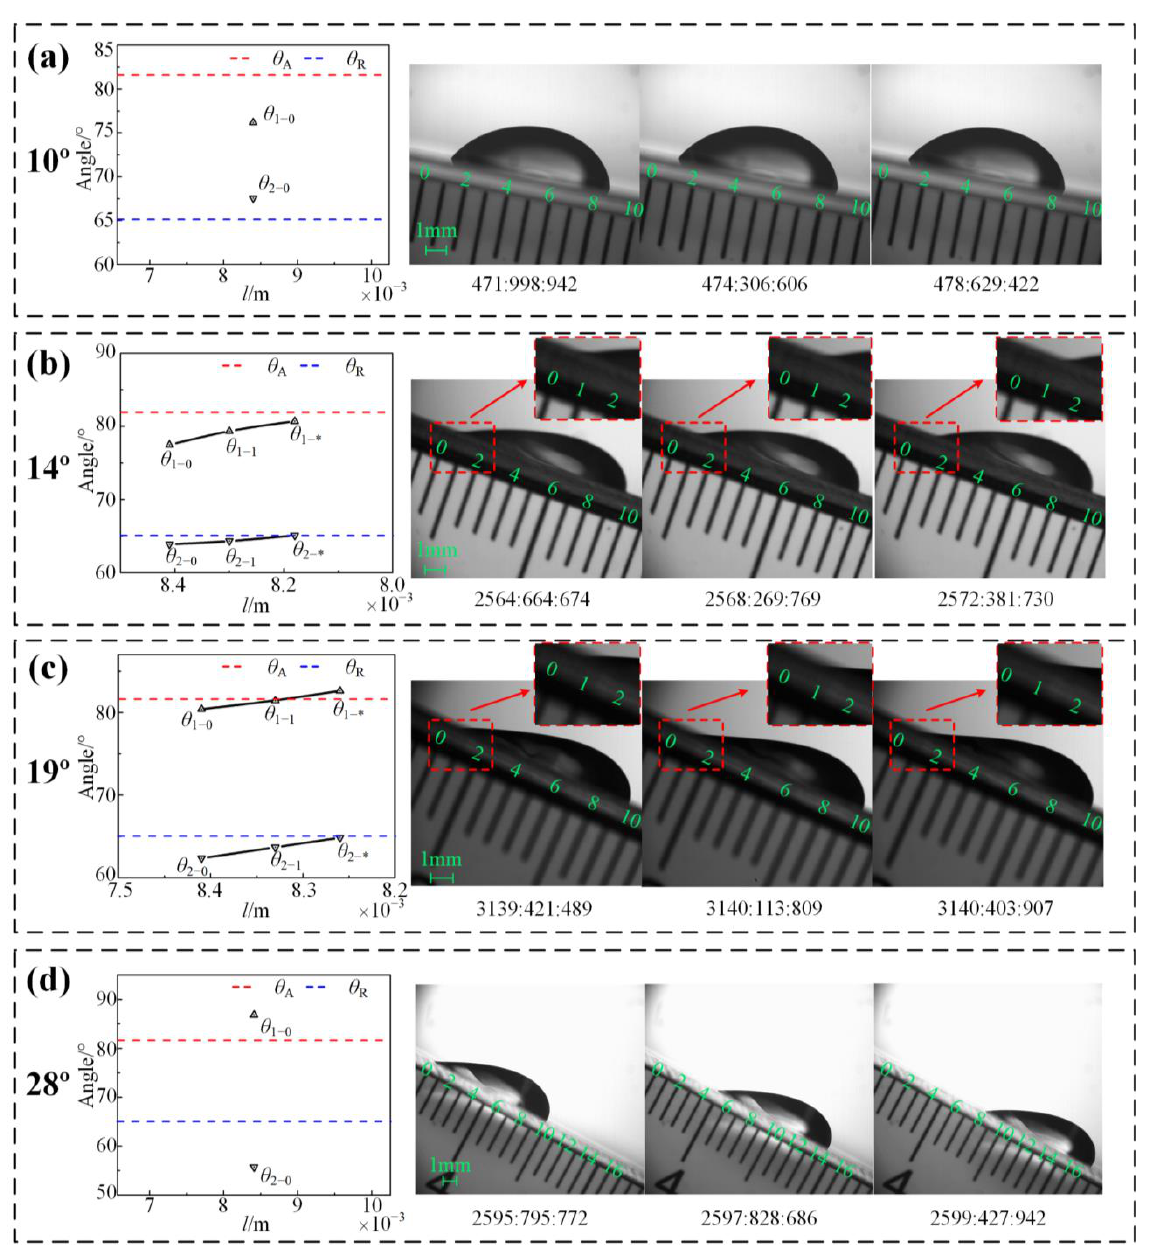
Figure 12. The simulations, predictions, and experiments of droplets on the inclined, smooth PMMA surface, where V = 60